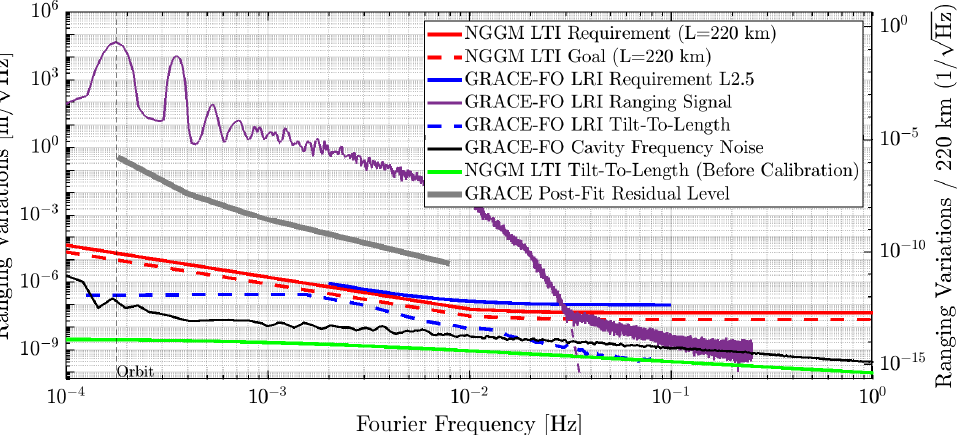
Figure 3. NGGM LTI requirements of 40 nm/ √ Hz (goal: 20 nm/ √ Hz) multiplied with a noise-shape function (cid:3495)(cid:4672)1 + (cid:2869) (cid:3040)(cid:3009)(cid:3053) in red, with the typical ranging signal in purple. The expected tilt-to-length effect is shown before post-processing corrections in green. The GRACE-FO LRI level 2.5 requirement as the sum of 80 nm/ √ Hz and 40 nm/ √ Hz is shown as a solid blue curve, while the tilt-to-length effect as measured in-flight is depicted as a dashed blue curve. The GRACE-FO cavity stability is depicted as a black trace, as derived from pre-flight measurements.